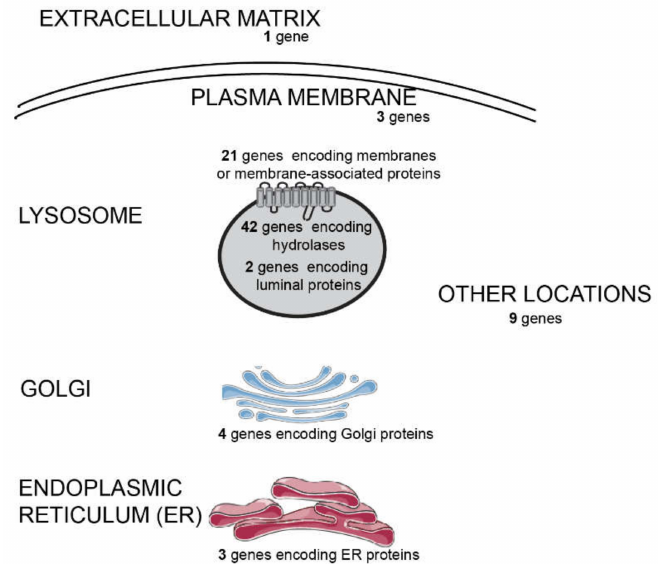
Figure 1. Subcellular distribution of the di ff erent gene products whose coding sequences were included in our next generation sequencing (NGS) panel designed to diagnose lysosomal storage diseases (LSDs) and related disorders. The panel is composed by 85 genes, as depicted: 65 genes encoding lysosomal proteins and 20 genes coding for non-lysosomal proteins. Some genes associated to diseases resembling LDSs or genes encoding proteins associated with lysosome-related organelles (LROs) were also covered, in such a way that, from a pathophysiological point of view, the panel includes 54 LSD-related genes, 13 which are disease-causing but non-LSD-related, and 18 not previously associated to disease. The non-LSD-disease-causing genes include three involved in LRO disorders and 10 whose deficiency is known to underlie disorders with overlapping